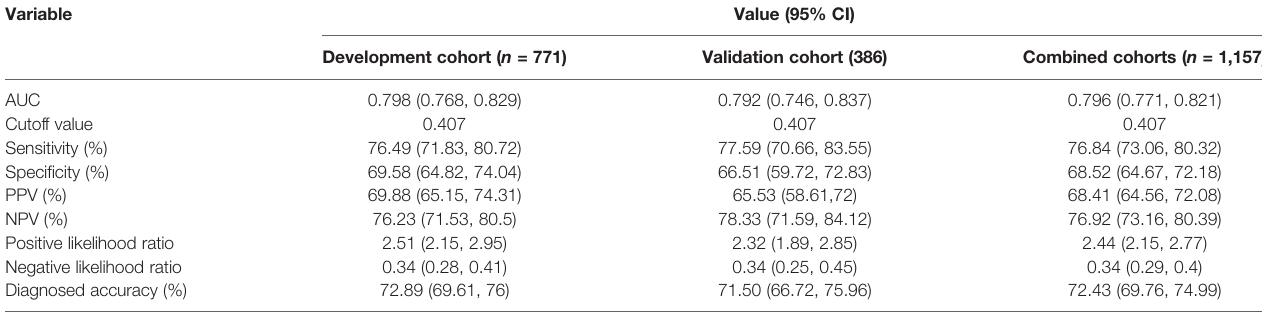
TABLE 3 | Performance of the prediction model for assessing the risk of CLNM. Variable